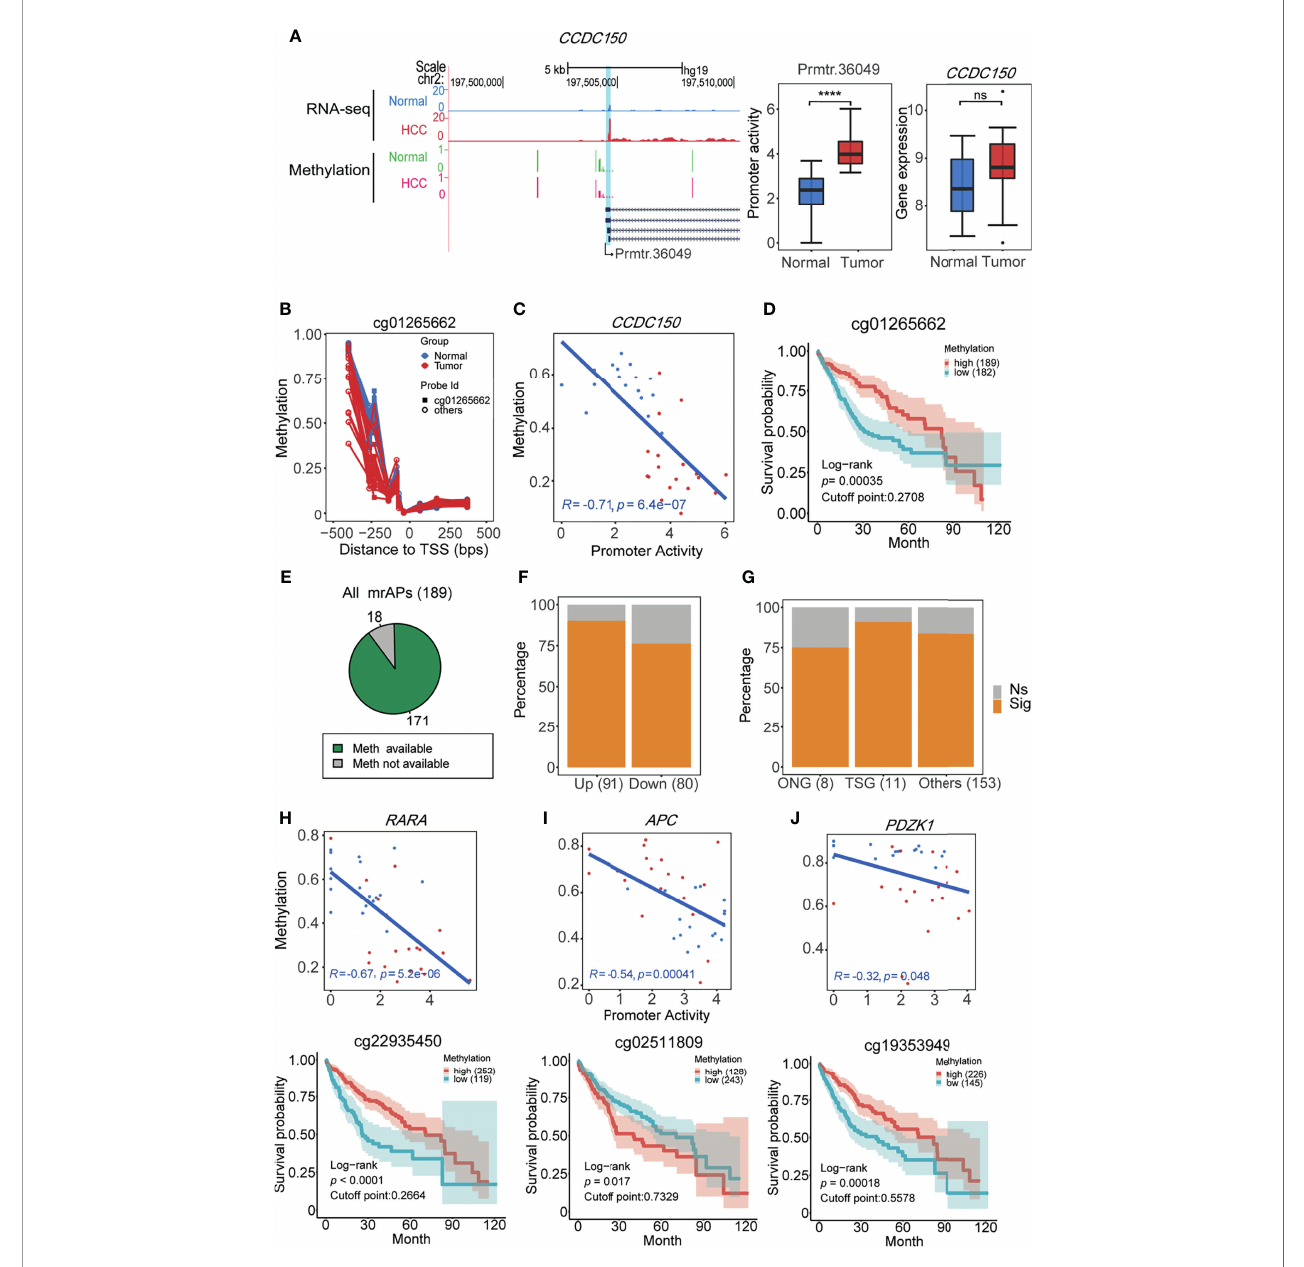
FIGURE 5 | The methylation status of APs predicts patient survival in HCC. (A) UCSC genome browser screenshot showing mean read count (top 2 tracks) and 450K methylation beta values (bottom 2 tracks) at the CCDC150 gene locus of HCC (red) and normal tissues (blue or green). The statistical results are shown in the middle (boxplot for promoter activity, **** p -value <0.0001 (ANOVA, p -value = 1.14e-07)) and right (boxplot for gene expression, ns: not signi fi cant. p-value > 0.05 (ANOVA, p-value = 0.12)). (B) Methylation beta values of ±500 bps relative to TSS (prmtr.36049). Normal and tumor samples are colored by green and red dots, dots from the same sample were connected by lines. Cg01265662 with the lowest p -value for the correlation test was marked and screened for calculation in (C) and (D) . (C) The scatter plot showing the negative correlation between promoter activities of prmtr.36049 and methylation beta values of cg1265662 in HCC (red) and normal (blue) samples (Pearson correlation). (D) The 10-year overall survival curve of methylation levels of cg1265662 in TCGA-LIHC patients in the high and low methylation cohort, showing that methylation of cg1265662 was signi fi cantly associated with survival in HCC. (E) The pie plot showing the majority of mrAPs with methylation values available in TCGA-LIHC. (F) The proportion of mrAPs with signi fi cant prognostic CpG methylation sites in upregulated and downregulated ones. (G) The proportion of genes with signi fi cant prognostic CpG methylation sites in mrAPs grouped by oncogenes (ONG), tumor suppressor genes (TSG), and others. (H – J) The correlations between promoter activity and methylation levels (upper) similar to (C) and corresponding survival curve of CpG sites (bottom) similar to (D) of RARA (H) , APC (I) , and PDZK1 (J) were shown,